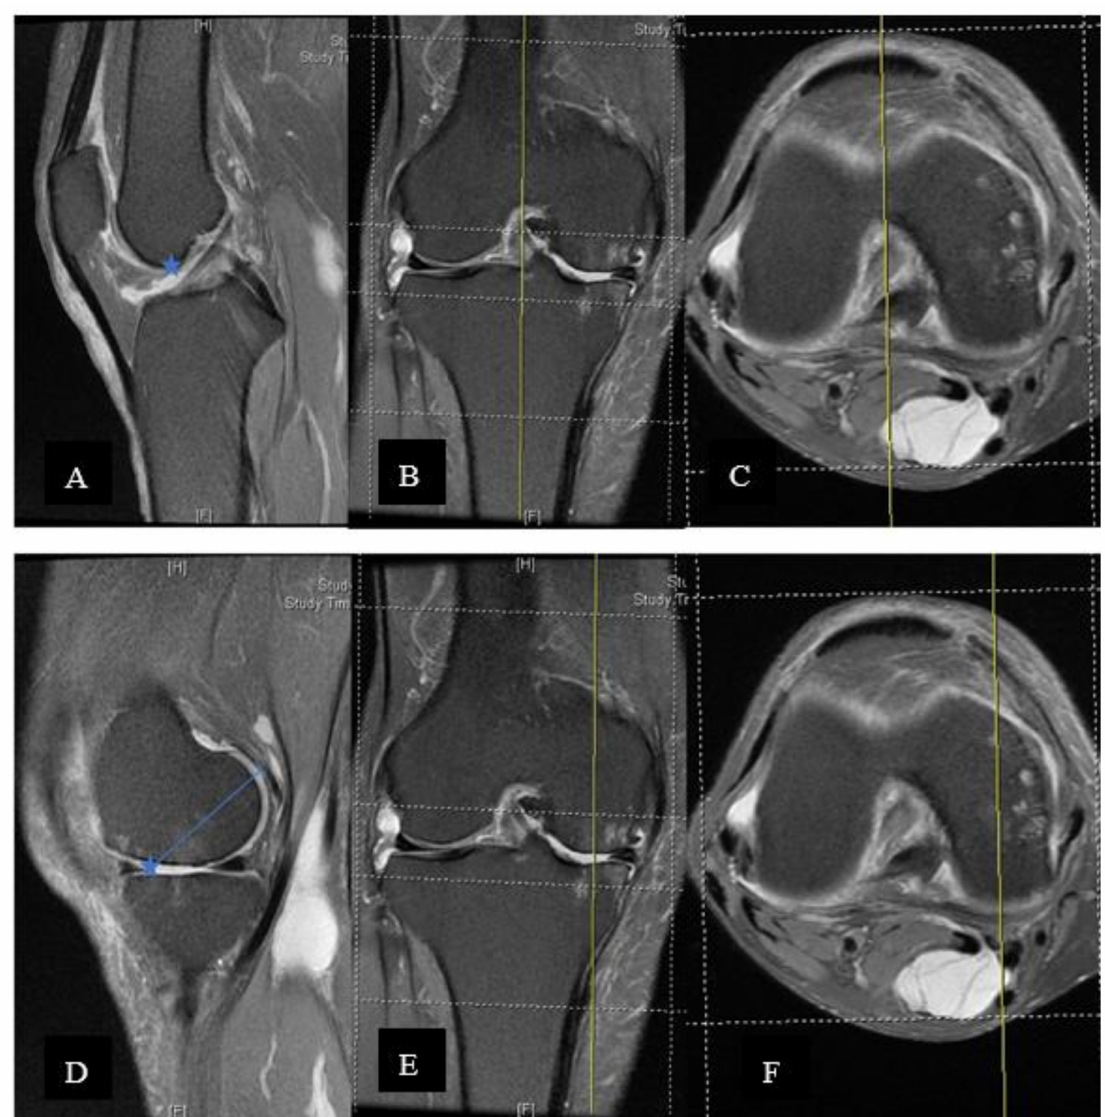
Figure 5. ( A – C ) On the sagittal section, the cut that bisected the trochlea was obtained, confirming the axial and coronal sections. The corner between trochlea and blummensant line was identified and marked (star). ( A ) Central sagittal cut of the knee MRI. ( B ) Coronal cut of the knee MRI. ( C )Axial cut of the knee MRI. ( D – F ) The marked point was transferred to the sagittal section at the central cut of the medial femoral condyle (also have to check on the axial and coronal planes). The marked point would estimate the most anterior point of the medial femoral condyle. The most posterior point included the visualised and marked cartilage. A full thickness loss of cartilage is usually observed at the anterior region. The cartilage thickness should be added back. ( D ) Sagittal cut through medial femoral condyle of the knee MRI ( E ) Coronal cut of the knee MRI ( F ) Axial cut of the knee